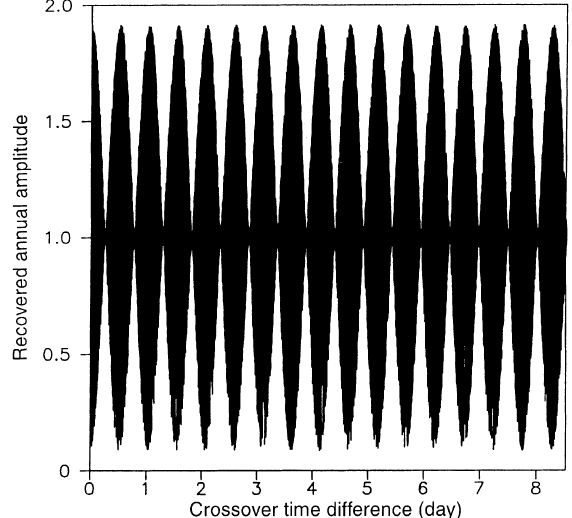
Fig. 7. The recovered amplitude of an annual harmonic signal with respect to the crossover time di(cid:128)erence between successive ascending and descending samples. The M2 tide is used as perturbation and the simulation duration is